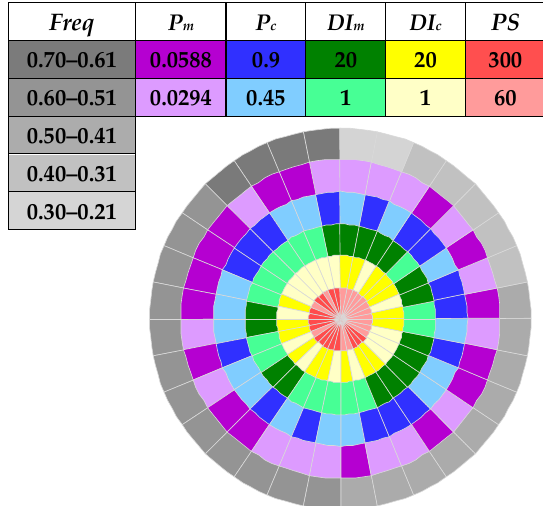
Figure 4. Parameterization of NSGA-II applied to the Hanoi Network (HAN) design problem.